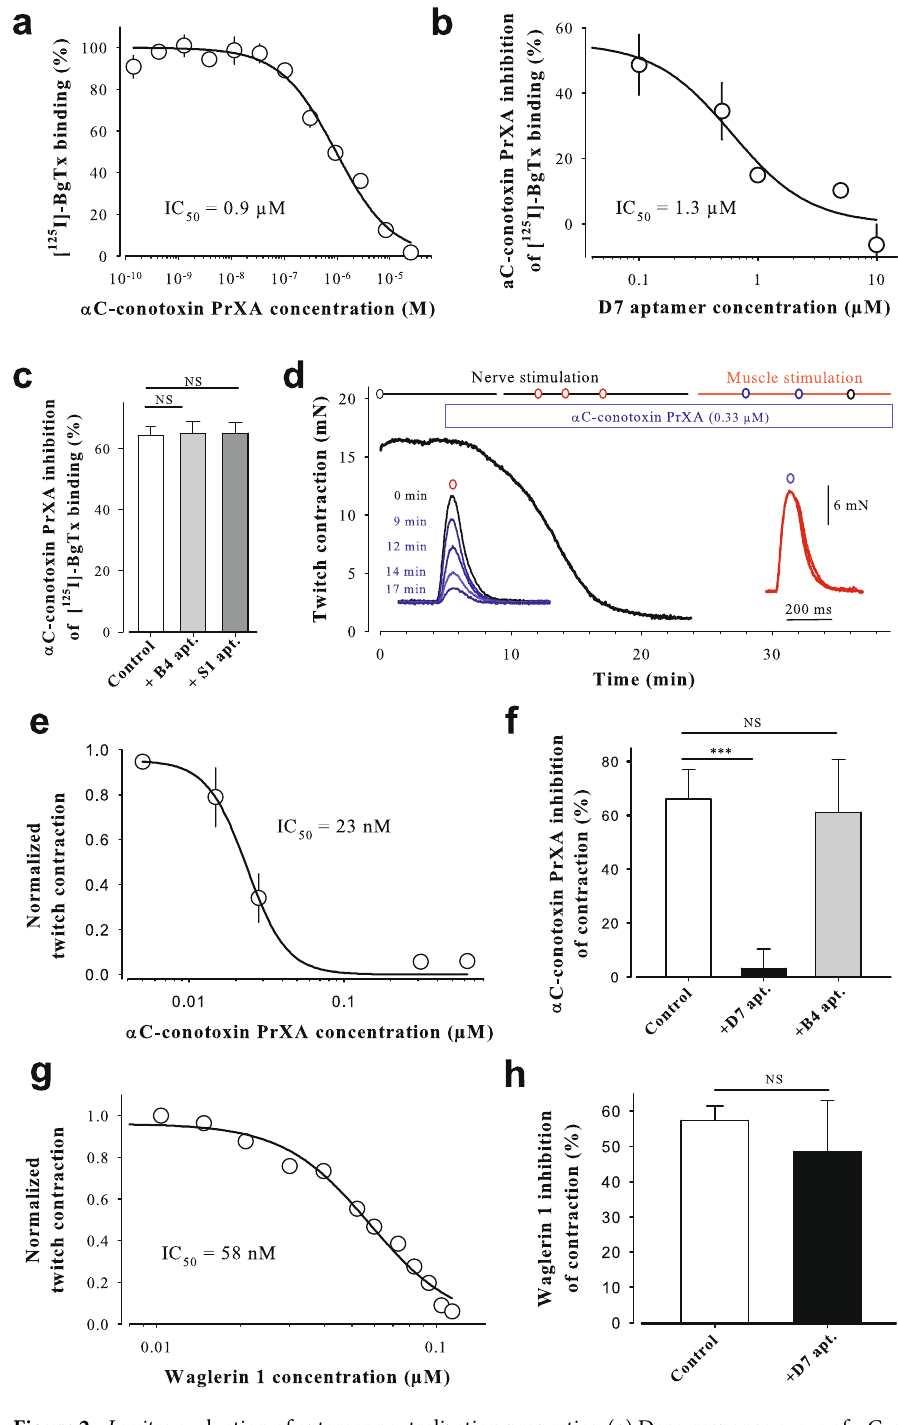
Figure 2. In vitro evaluation of aptamer neutralization properties. ( a ) Dose-response curve of α C-conotoxin PrXA-mediated inhibition of 1 nM [ 125 I]- α -BgTx binding. ( b ) Effect of D7 aptamer on α C-conotoxin PrXA- mediated inhibition of [ 125 I]- α -BgTx binding. ( c ) Effect of B4 aptamer on α C-conotoxin PrXA-mediated inhibition of [ 125 I]- α -BgTx binding. ( d ) Time-dependent inhibition of muscle contraction by 0.31 µ M α C- conotoxin PrXA (left inset). Lack of toxin effect on direct muscle stimulation (right inset). ( e ) α C-conotoxin PrXA dose-dependence of muscle contraction inhibition. IC 50 = 23 nM. ( f ) Effect of D7 and B4 aptamers on 28 nM α C-conotoxin PrXA-mediated inhibition of muscle contraction. D7 at 20x molar, B4 at 45x molar concentration. ( g ) Waglerin 1 dose-dependence of muscle contraction inhibition. ( h ) Effect of D7 aptamer on waglerin 1-mediated inhibition of muscle contraction. N.S.: nonspecific; *** : p ≤